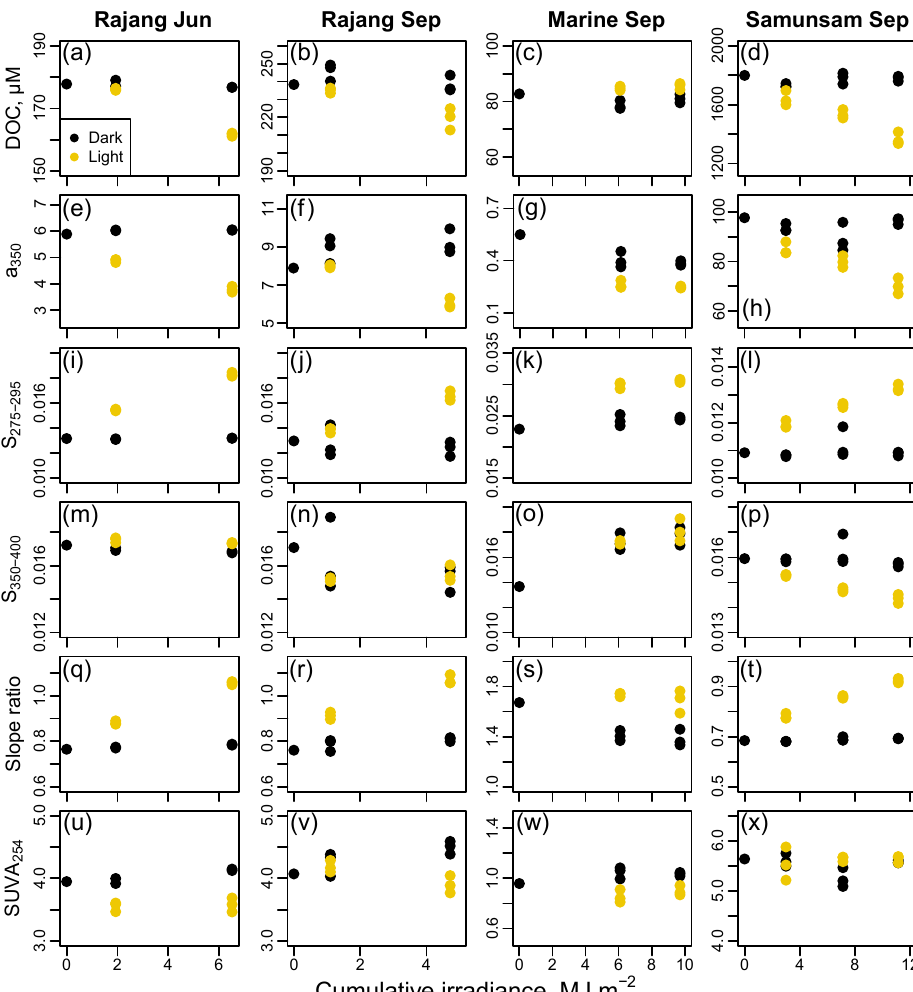
Figure 6. Results from photodegradation experiments showing the decrease in DOC (a–d) , CDOM concentration (e–h) , S 275–295 (i–l) , S 350–400 (m–p) , CDOM spectral slope ratio (q–t) , and SUVA 254 (u–x) with cumulative irradiance from 318 to 450nm in wavelength. Each column corresponds to one degradation experiment, as indicated in the column titles. Black symbols indicate dark control bottles; yellow symbols indicate light-exposed